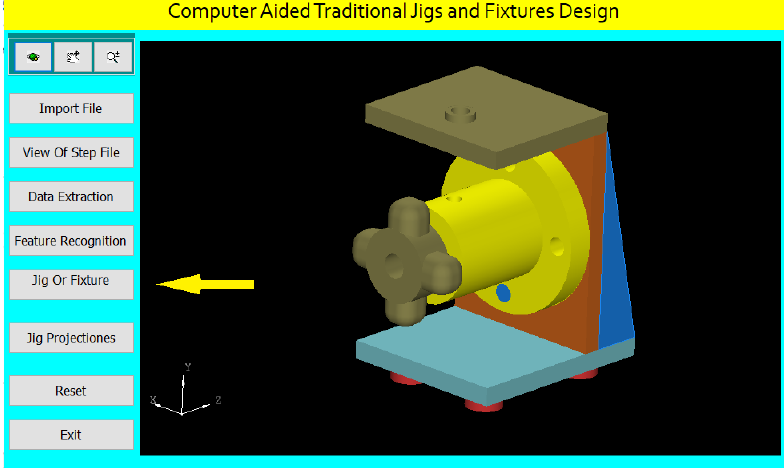
Figure 14. The fifth screen of the system interface.